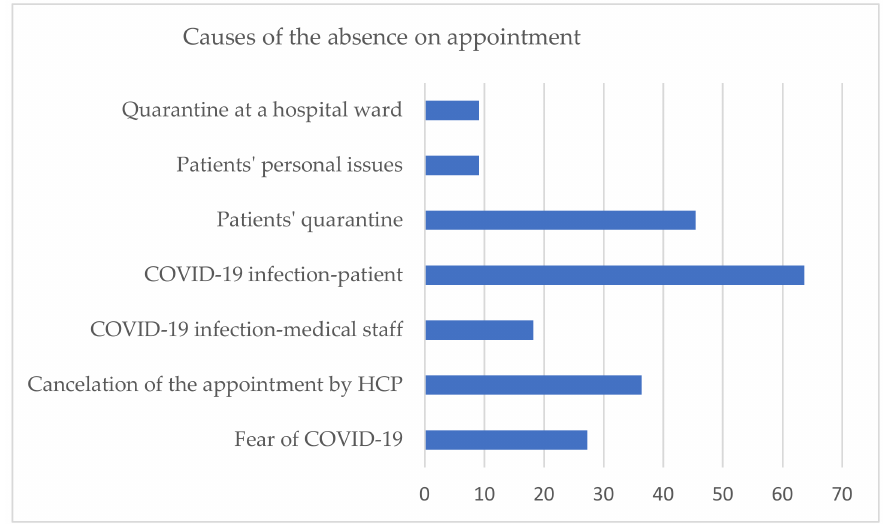
Figure 2. The causes of absence on appointments (HCP—health care